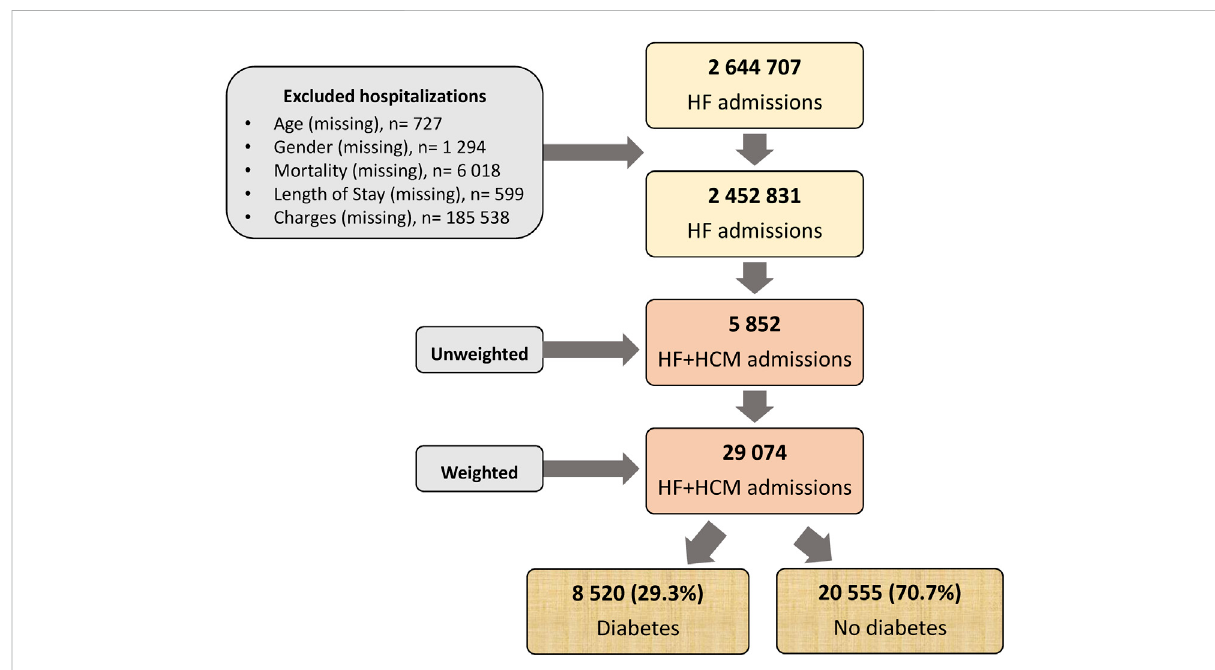
FIGURE 1 Flow chart of the study. HCM, Hypertrophic cardiomyopathy; HF, heart